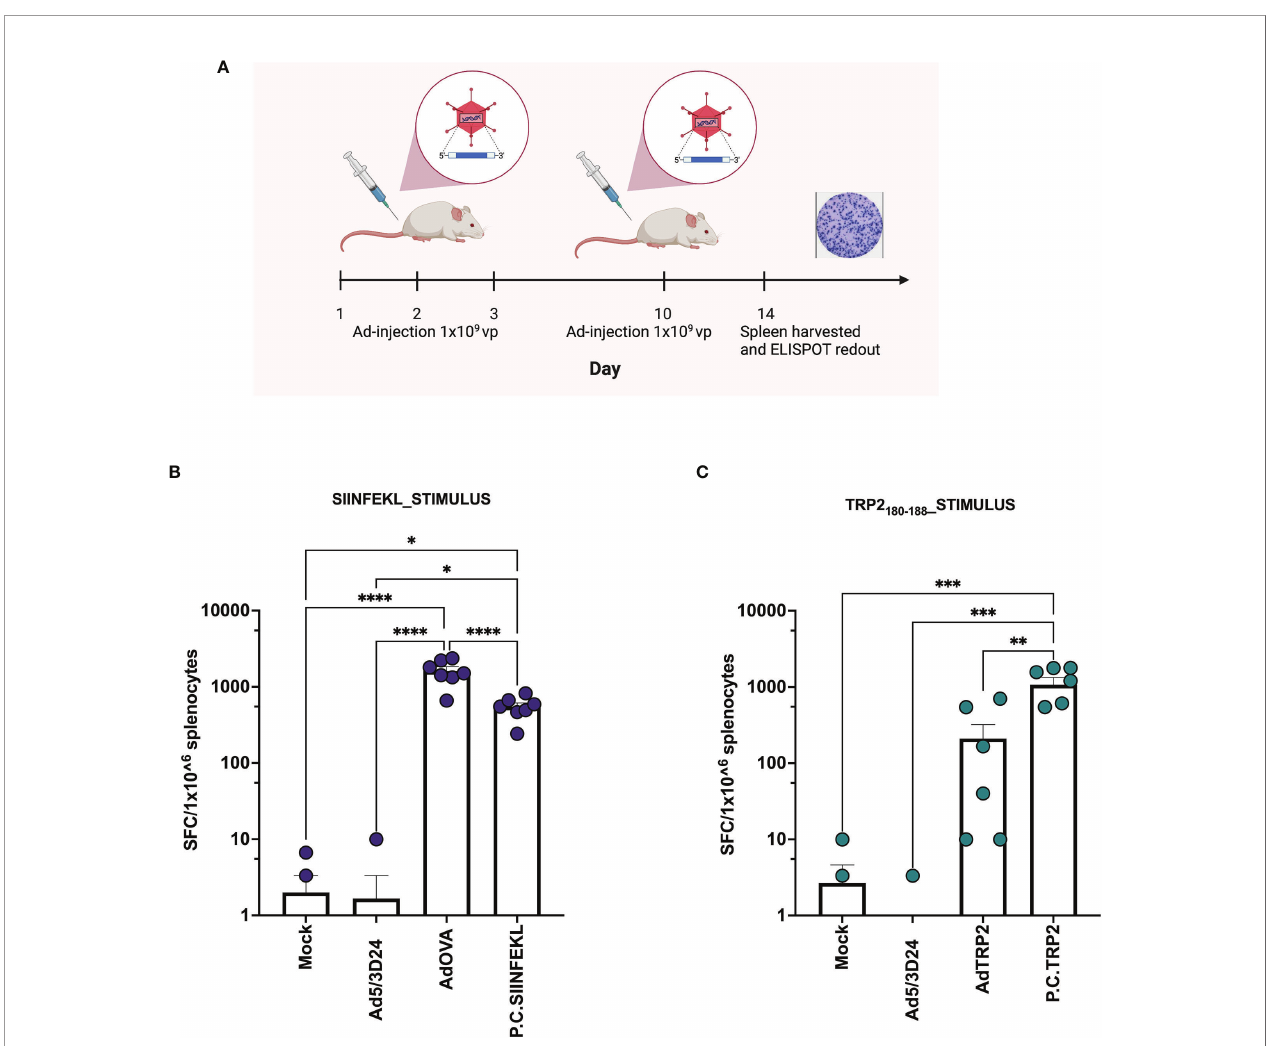
FIGURE 3 | Ad encoding TAs and PeptiCRAd show in vivo prophylactic ef fi cacy. (A) Schematic representation of the schedule followed during the vaccination procedure. The mice have been subcutaneously injected with Ad5/3 D 24, PeptiCRAd (P.C. SIINFEKL, P.C. TRP2), cloned viruses (AdOVA, AdTRP2) or PBS (Mock) at day 1,2,3 and 10. The spleens were harvested at day 14. (B, C) IFN- g ELISpot was performed on harvested splenocytes and individual response to SIINFEKL (B) and TRP2 (C) for each mouse is reported as IFN - g spot forming cells (SFC)/10 6 splenocytes. The data are depicted as bar plot and mean + SEM is shown. (P.C.=PeptiCRAd) and the statistical analysis was performed with ordinary One-way ANOVA (ns P > 0.05, *P ≤ 0.05, **P ≤ 0.01, ***P ≤ 0.001, ****P ≤ 0.0001). Created with BioRender